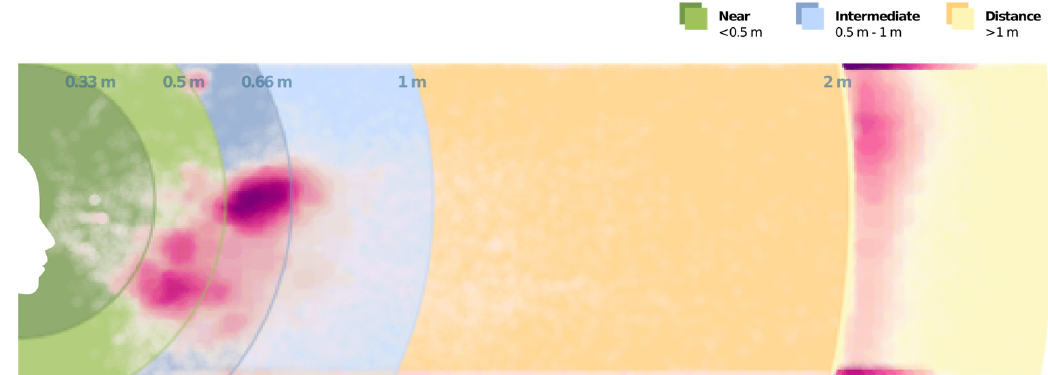
Figure 3. Mapping of viewing distances on two ‐ dimensional plane using head flexion information (Patient A). Dense areas reflect the computer work and handheld devices. Color coding for the vision zones is the same as in Figure 2.